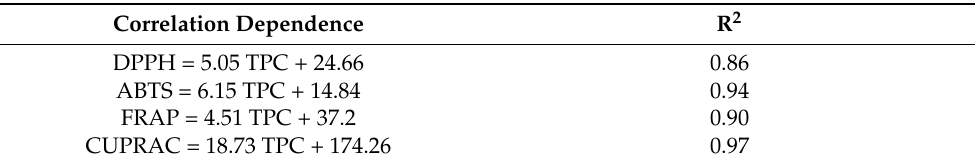
Table 7. Correlation dependences between TPC and antioxidant activity for blossoms of Sambucus nigra L. from Bulgaria. Correlation